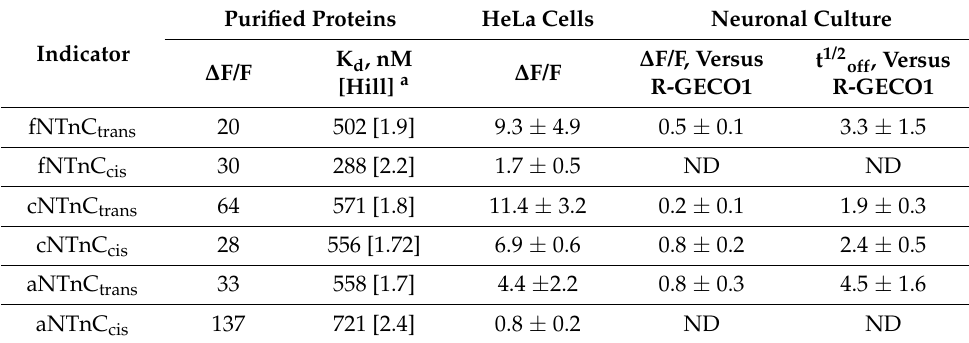
Table 2. Properties of fNTnC, cNTnC, and aNTnC indicator variants. a K d was measured in buffer containing 1 mM MgCl 2